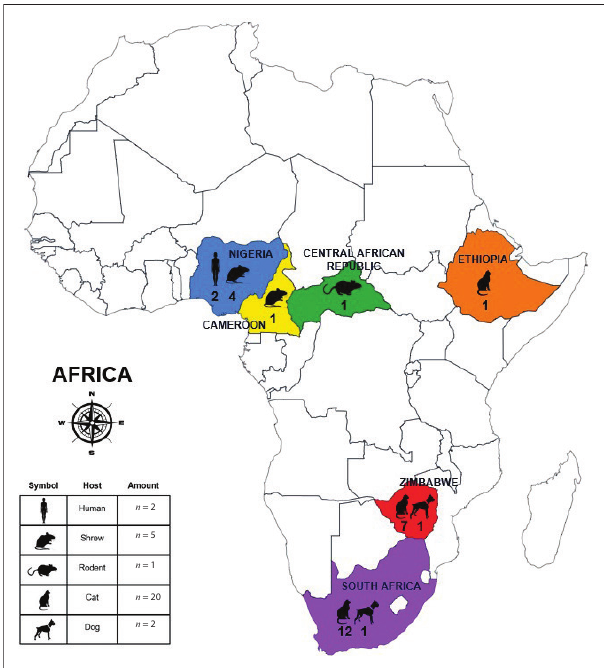
FIGURE 1: Geographical distribution of all reported Mokola virus cases ( n = 30) in the African continent.